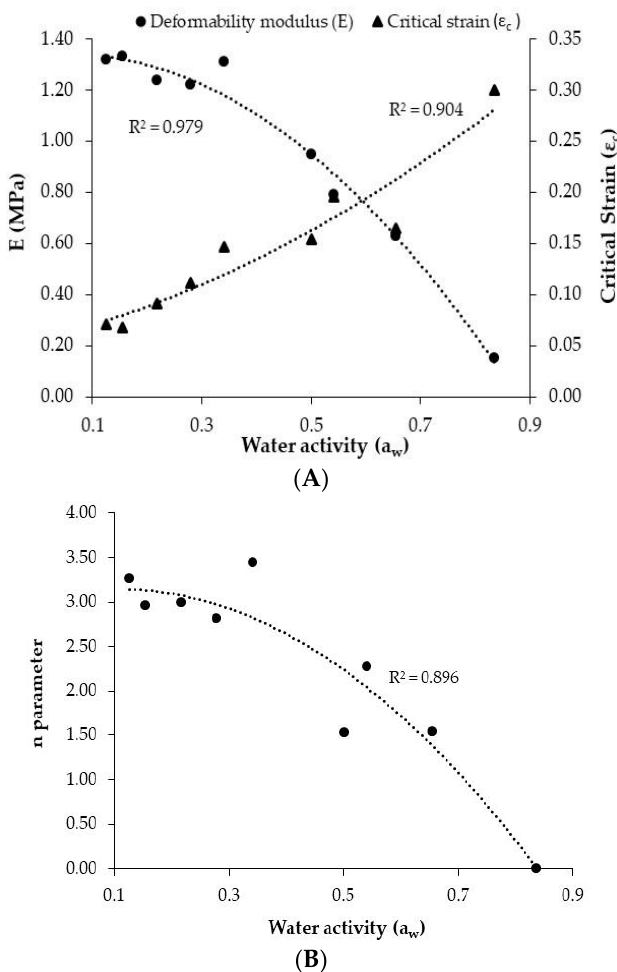
Figure 8. Relationship of the deformability modulus ( E ) ( A ), the critical strain ( ε c ) ( A ) and the curvature parameter ( n ) ( B ) with the water activity (a w ) of puffed corn cakes (PCC).